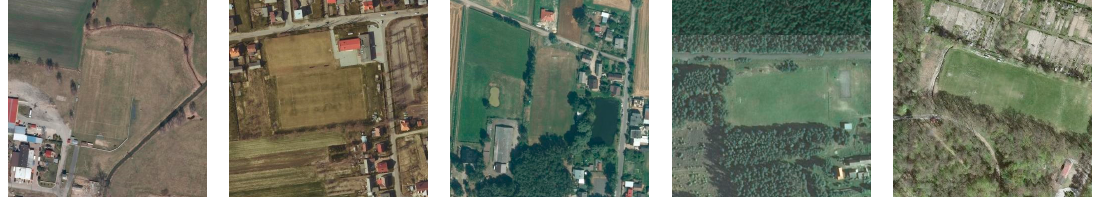
Figure 9. Di ff erent cases where it is di ffi cult for soccer fields to be identified, even by expert